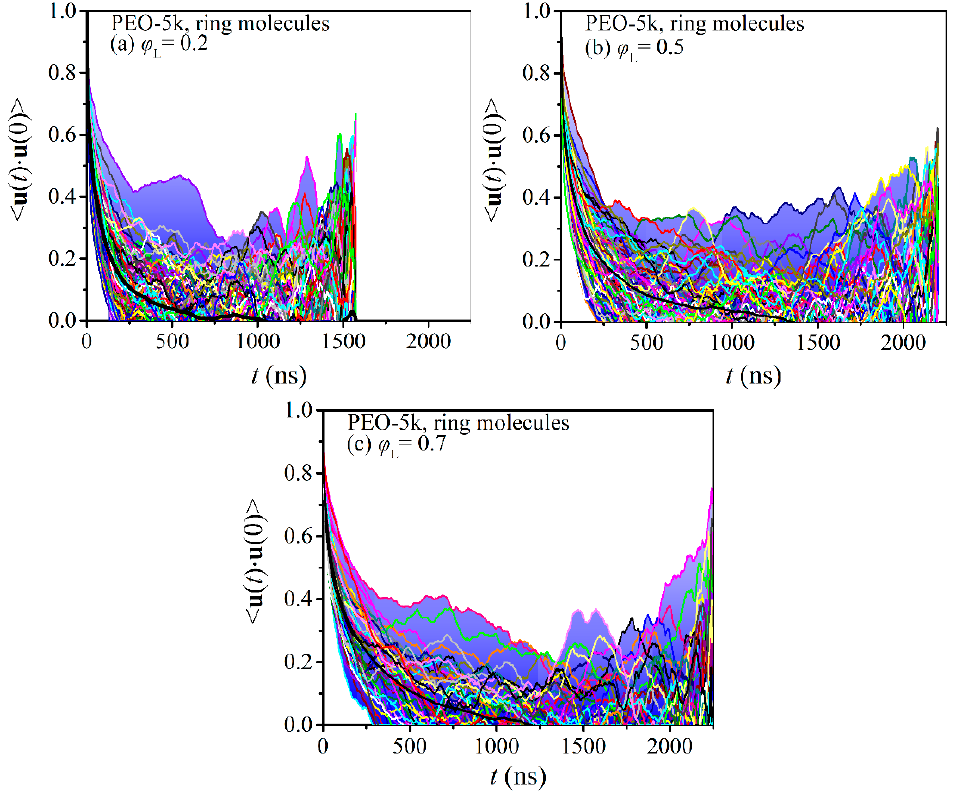
(cid:10) (cid:11) u ( t ) · u ( 0 ) for each ring PEO molecule separately ( ) ( ) ⋅ t 0 u u for each ring PEO molecule